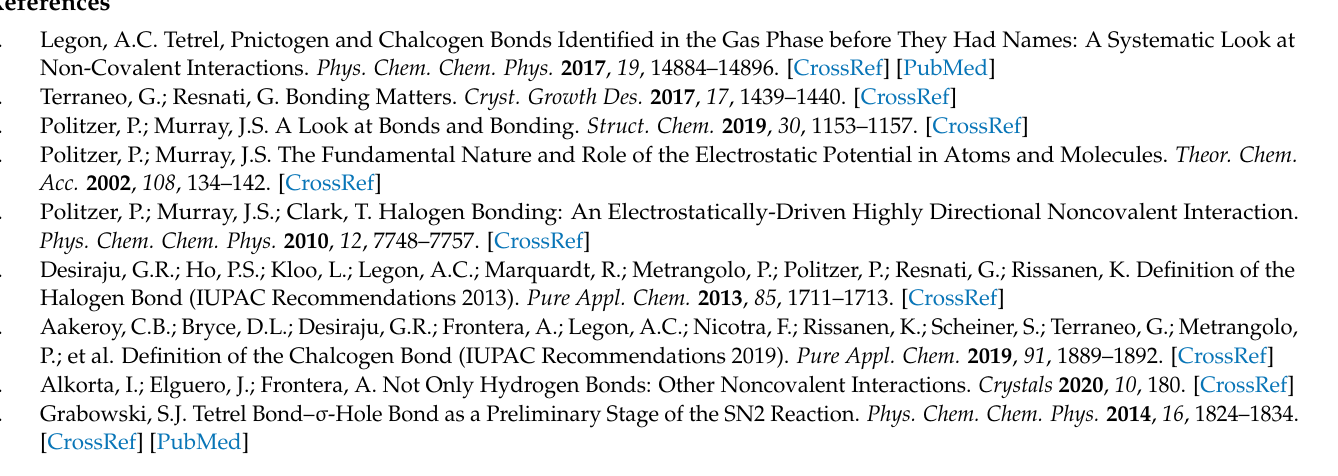
Table S1: Bond lengths and electron density at critical points (a. u.) for Tt–Y and Tt–Hal interactions in complexes Y–TtX 3 . . . Hal – ; Table S2: Properties of the static, electrostatic, and Pauli potentials for Hal – . . . Tt bonds in complexes Y–TtX 3 . . . Hal – ; Table S3: The static and electrostatic